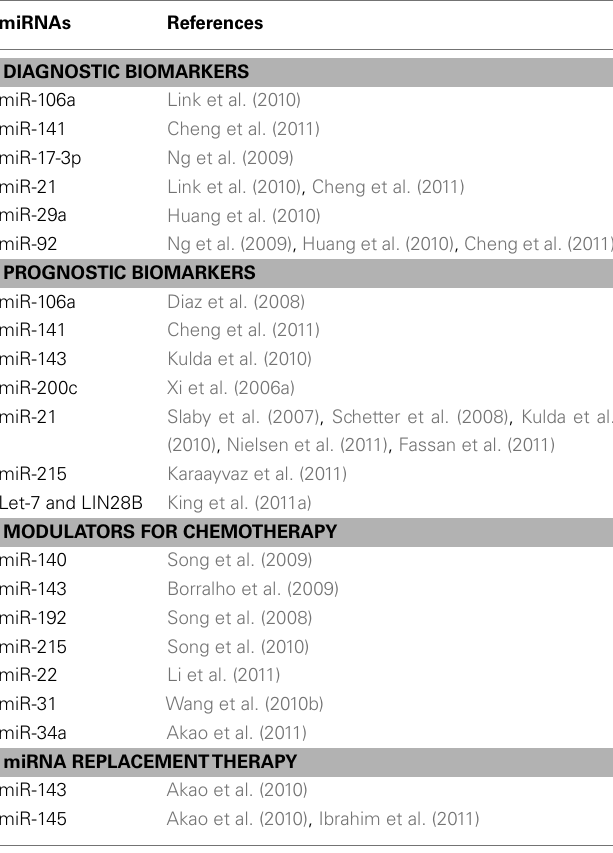
Table 1 | Biomarker and therapeutic candidates of miRNAs in colorectal